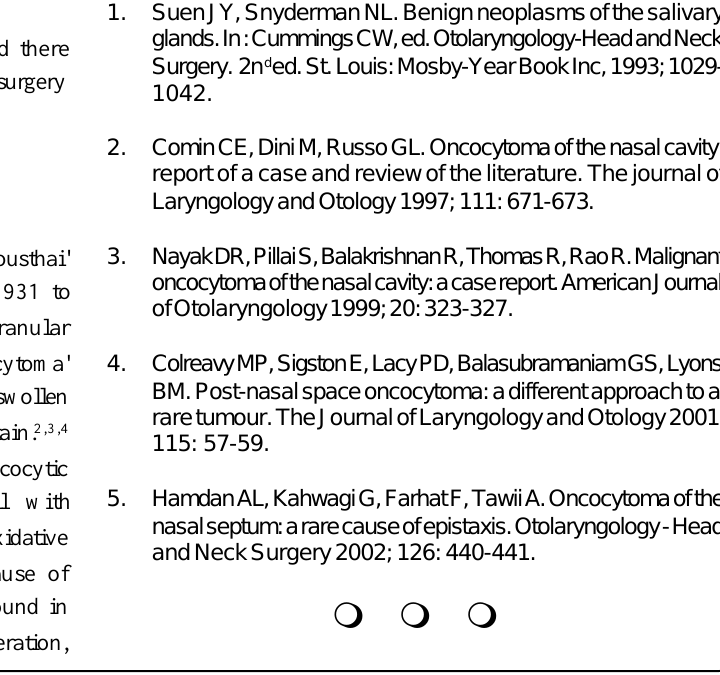
Fig.2: Microphotograph of oncocytoma of nasal cavity (H&EX100)